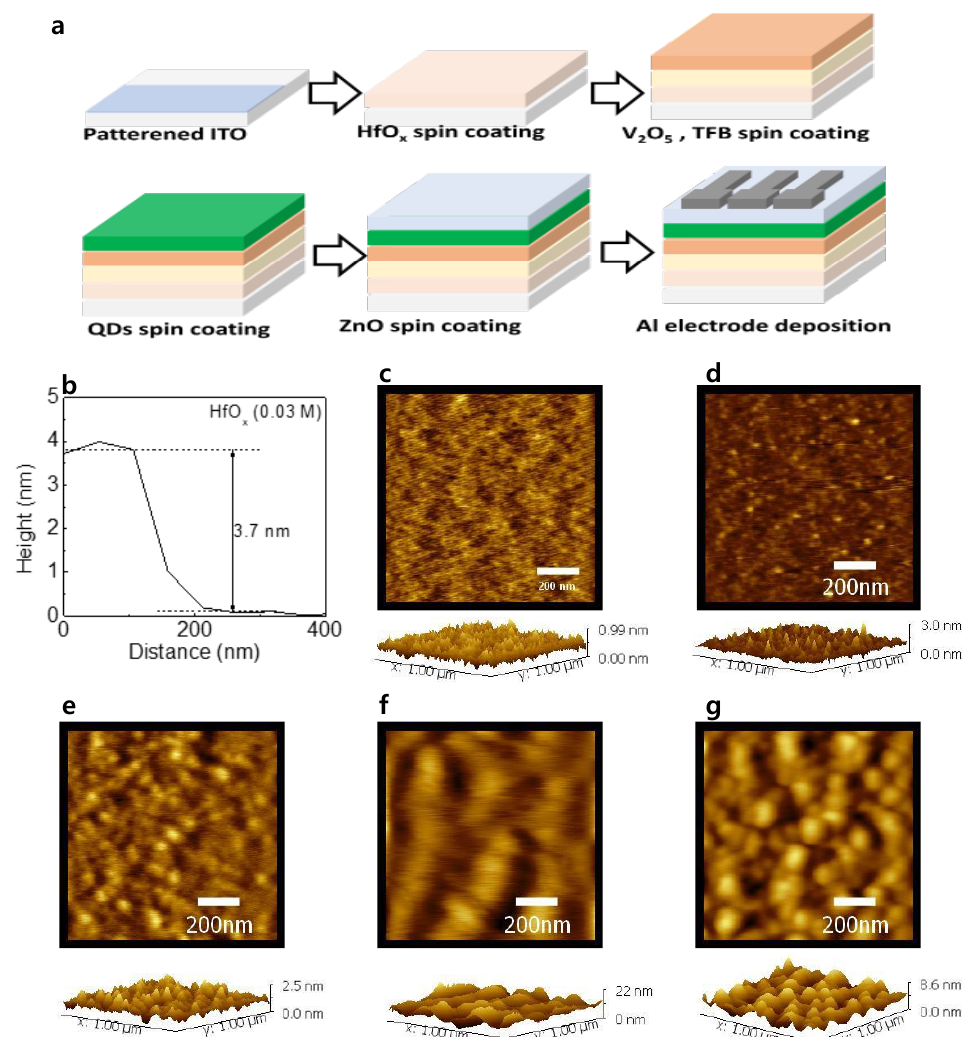
Figure 1. ( a ) Schematic illustration of the device fabrication. ( b ) Thickness of the HfO x (0.03 M) films obtained from AFM measurement. Surface morphology with 3D topography of ( c ) HfO x (0.03 M), ( d ) V 2 O 5 , ( e )TFB, ( f ) QD, and ( g ) ZnO